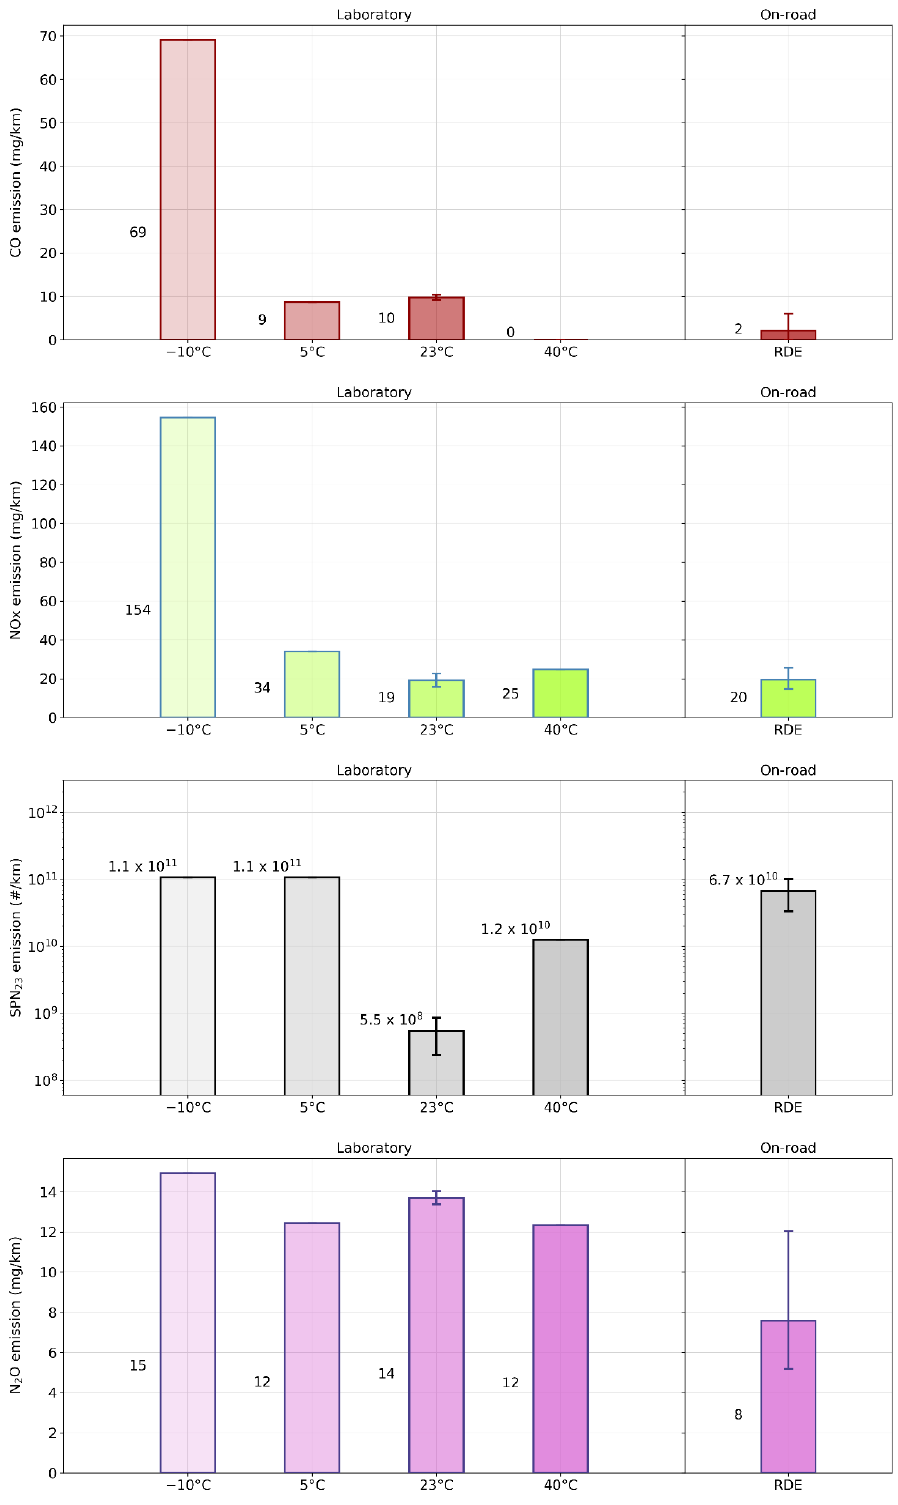
Figure 8. Emissions of regulated pollutants and N 2 O on: (left panels) labRDE tests as a function of temperature; (right panels) RDE route (when available). All the tests were performed with the minimum SOC and with the default user selectable mode of operation. Error bars on the graph represent maximum and minimum values for conditions having more than one test. See Methods section for additional details.